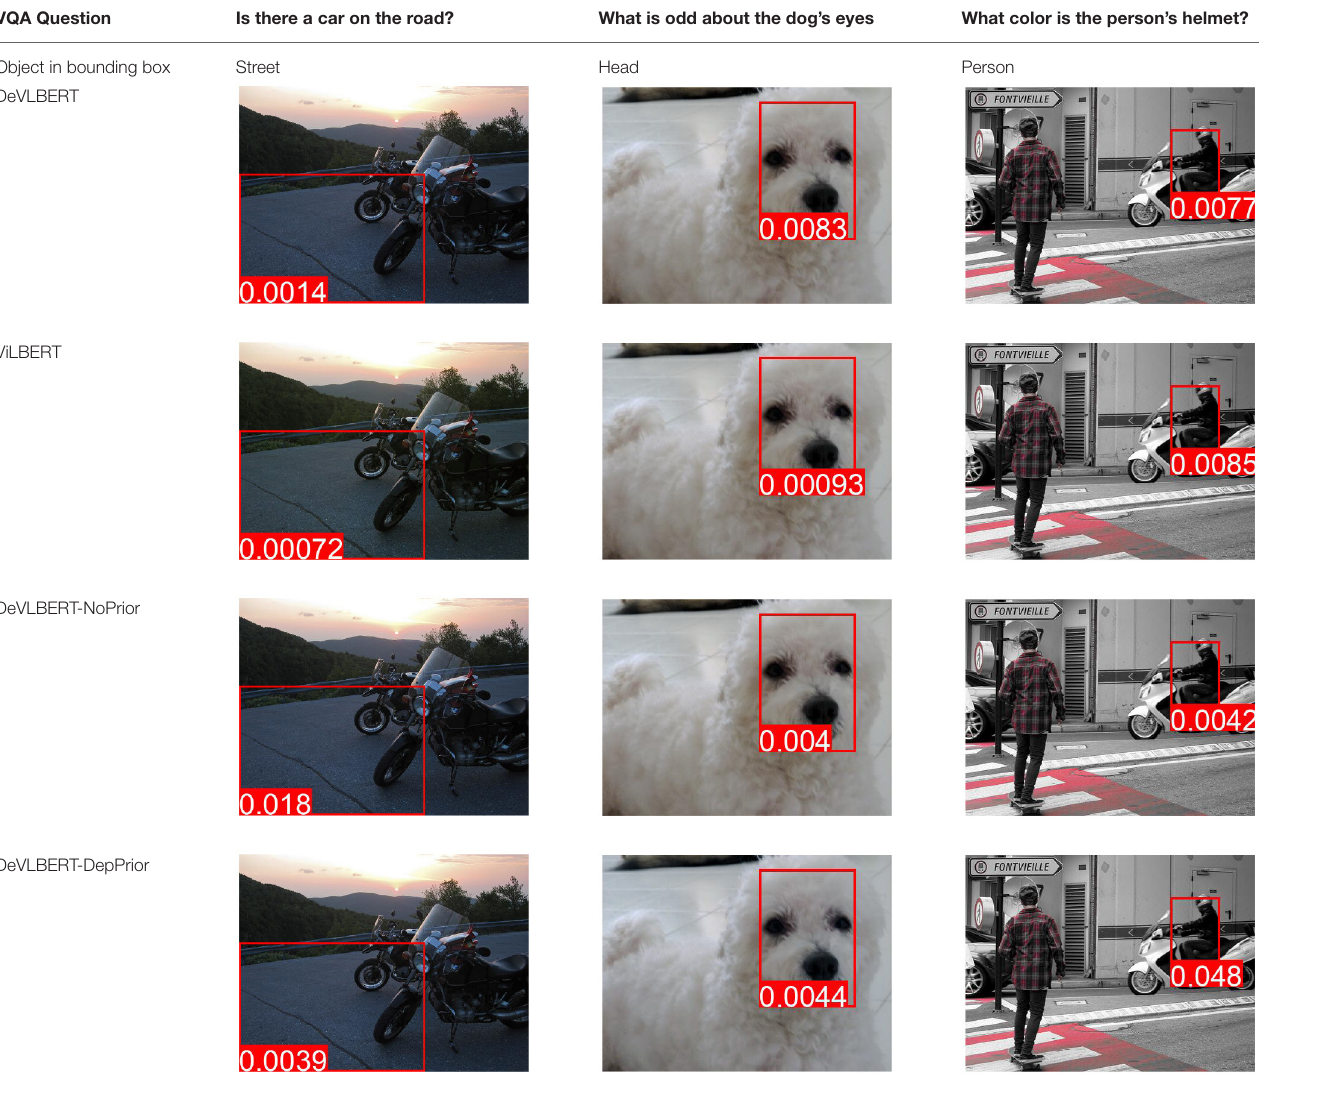
TABLE 8 | Some examples of the attention from query word to cause bounding box, for different models. VQA